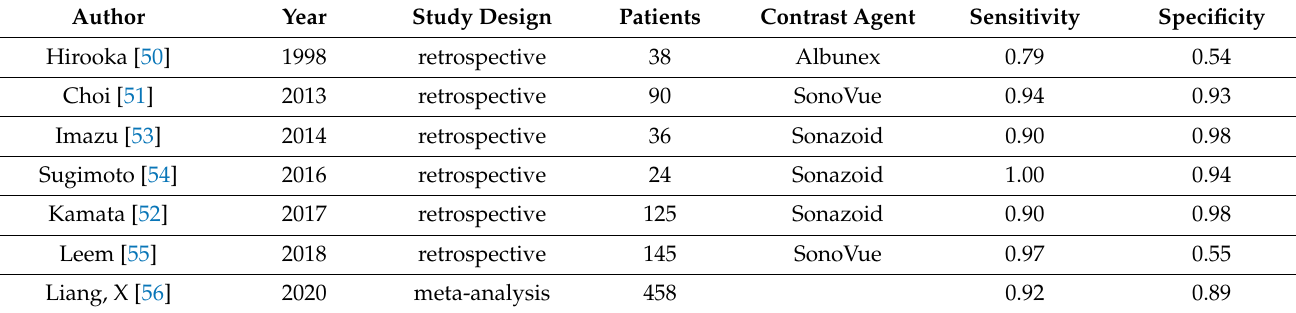
Table 6. The sensitivity and specificity on CH-EUS for the diagnosis of GB